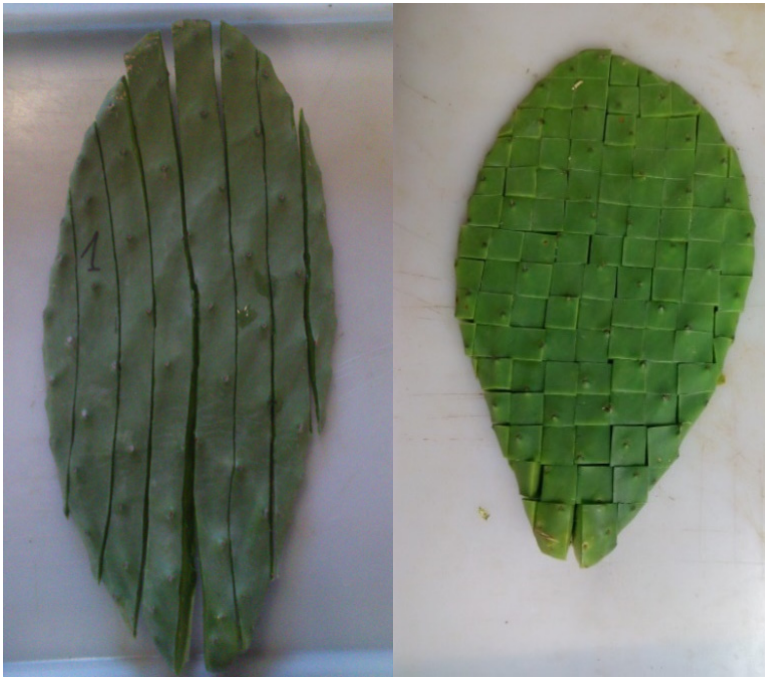
Figure 1. Prickly-pear-cladodes cut in straps ( left ) and cubes ( right ). The flat surfaces of the cladodes are known as faces, which are covered by an epider- mal tissue that hinders water evaporation in the natural plant. The face area of each clad- ode was estimated using the equation proposed by Saiz (Equation (1))